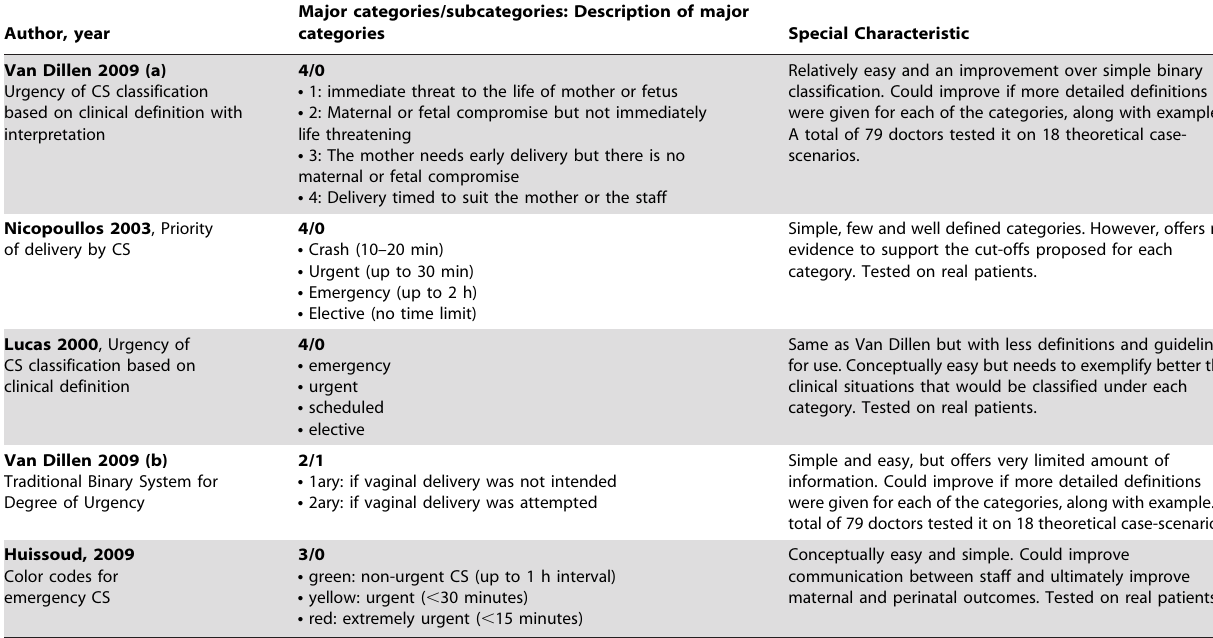
Table 5. Classifications for caesarean sections based on degree of